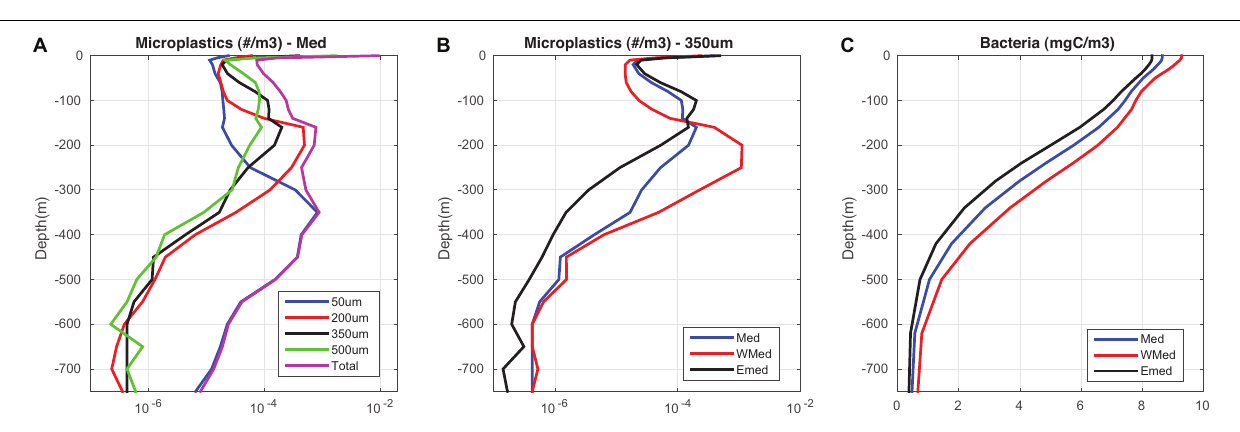
FIGURE 10 | Mean (2010–2017) model simulated beached macroplastics concentration (#/m).